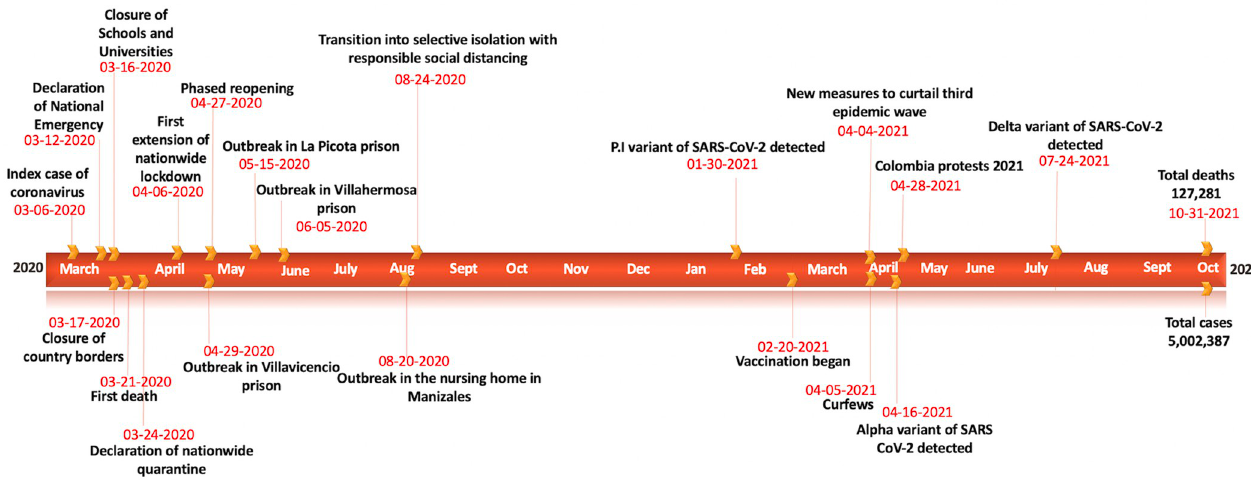
Fig 1. Timeline of the COVID-19 pandemic in Colombia as of October 31, 2021.